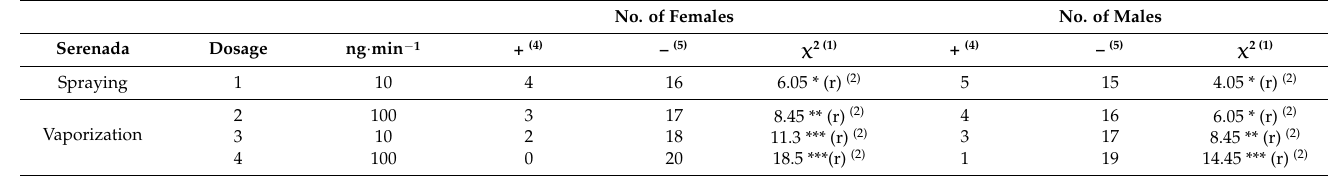
Table 5. Effect of volatile odours released by wheat plants cv. Serenada following methyl jasmonate exposure at two levels (10 ng min − 1 and 100 ng min − 1 ) on the number of Aelia acuminata L. adult females and males choosing to enter an arm of a four-way olfactometer. One arm contained the combination of odours, whereas the other arm contained purified, humidified air and hexane solvent (no odour) to act as the control. No. of Females No. of